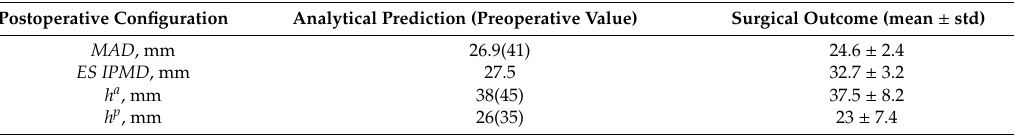
Table 2. Comparison between analytical predictions and surgical